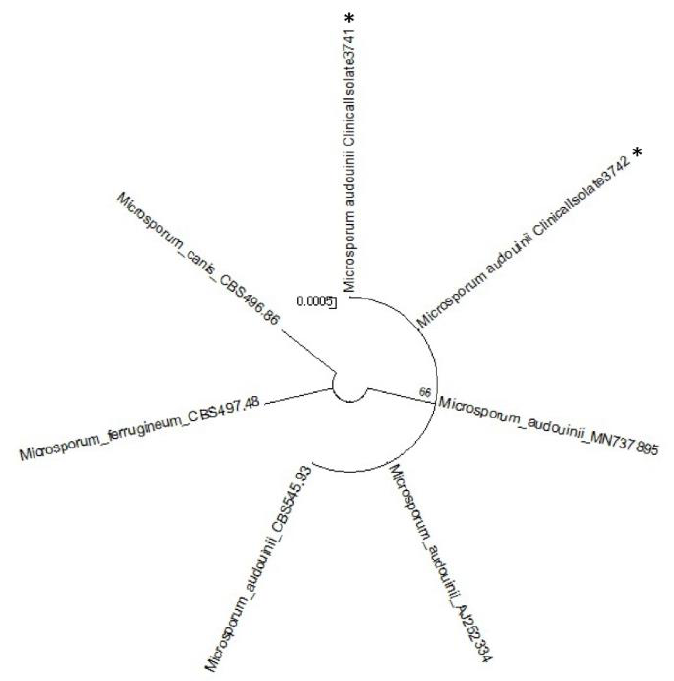
Figure 5. Molecular phylogenetic tree of the two strains of Microsporum audouinii from our study (shown with ＊ ).